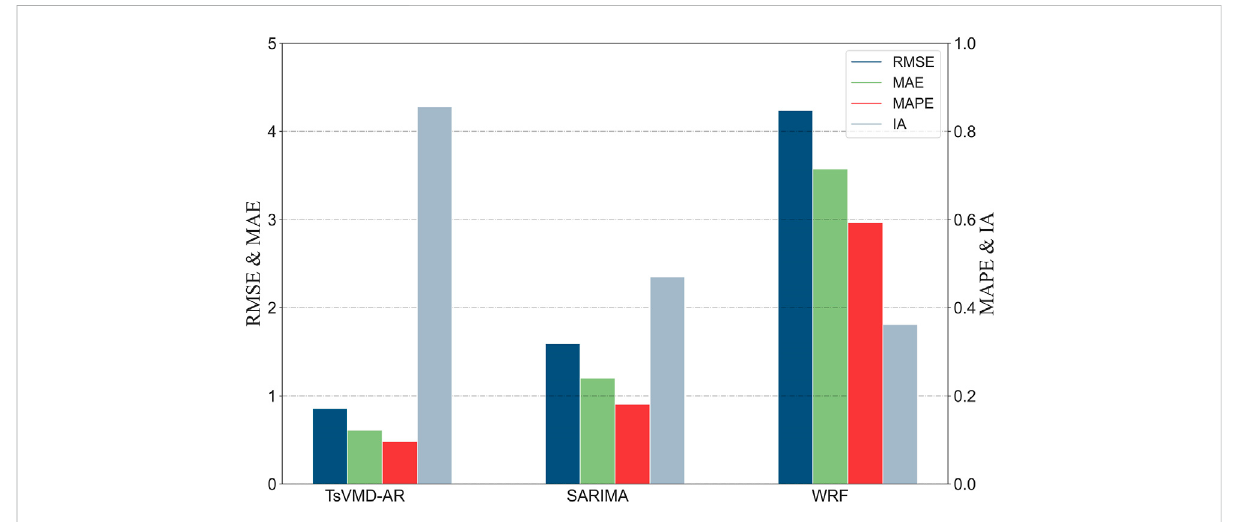
FIGURE 6 Evaluation criteria results of different forecasting models for period